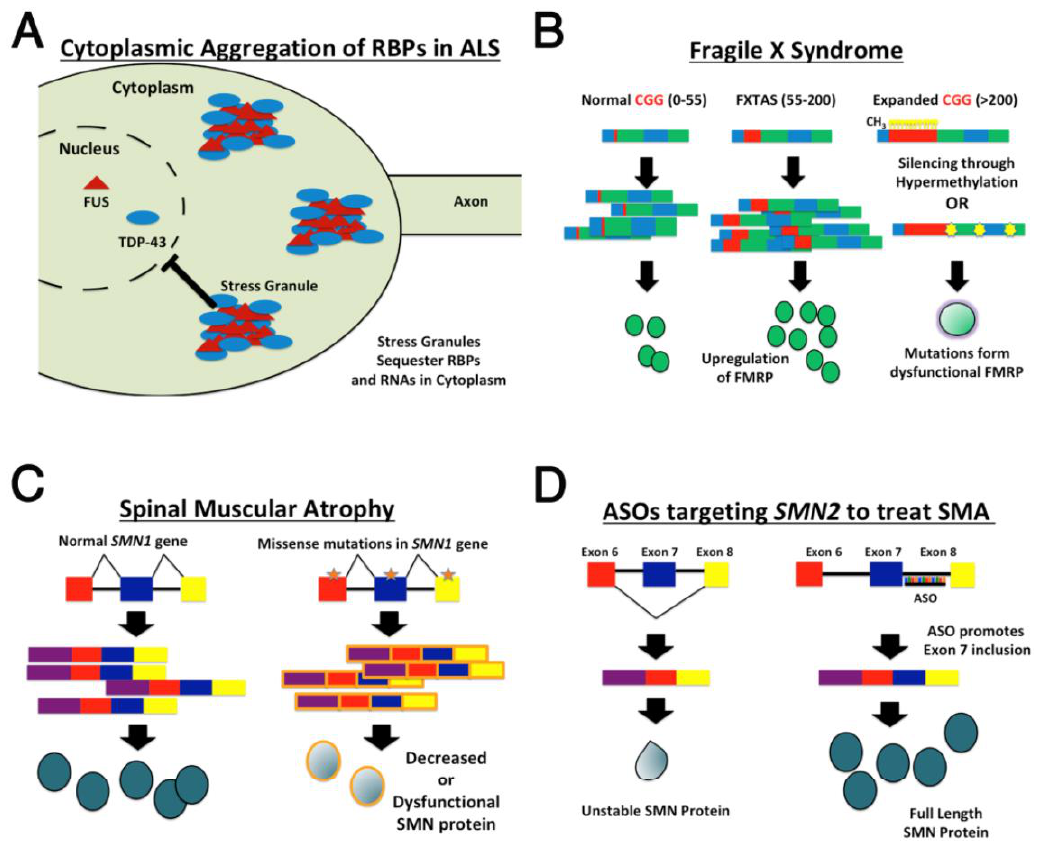
Figure 1. RBP dysfunction in neurological disease. ( A ) A subset of familial Amyotrophic lateral sclerosis (ALS) cases are caused by mutations in RBPs such as FUS and TDP-43. Aberrant forms of these proteins promote the formation of stress granules in the cytoplasm, sequestering RBPs and RNAs, and preventing the normal activities of FUS and TDP-43 in the nucleus; ( B ) Fragile X Syndrome (FXS) and FXTAS are caused by genetic lesions in the FMR1 locus. FXTAS is caused by the expansion of CGG repeats in the 5 (cid:48) end of the FMR1 such that individuals have between 55 and 200 repeats. This results in the upregulation of FMR1 . Patients with FXS, on the other hand, have more than 200 CGG repeats in the 5 (cid:48) region of FMR1 , which results in silencing of the FMR1 locus through hypermethylation. Other cases of FXS are caused by point mutations or deletions in the FMR1 locus that render FMRP nonfunctional; ( C ) Spinal muscular atrophy is caused by mutations in the SMN1 locus, which decreases the amount of functional SMN protein; ( D ) However, new antisense oligonucleotide (ASO) technology has been developed to target SMN2 , a paralog of SMN1 . SMN2 cannot normally compensate for loss of SMN1 , because splicing of SMN2 results in exclusion of exon 7, rendering the SMN protein unstable. ASOs have been developed to promote exon 7 inclusion during splicing of SMN2 , thus increasing the amount of functional SMN protein.